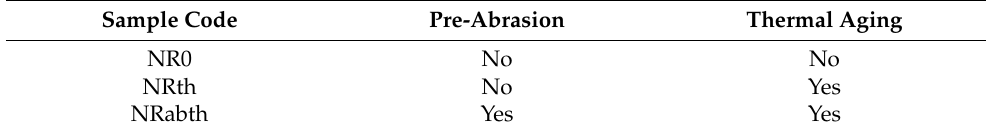
Table 1. Sample codes according to the pre-abrasion and thermal